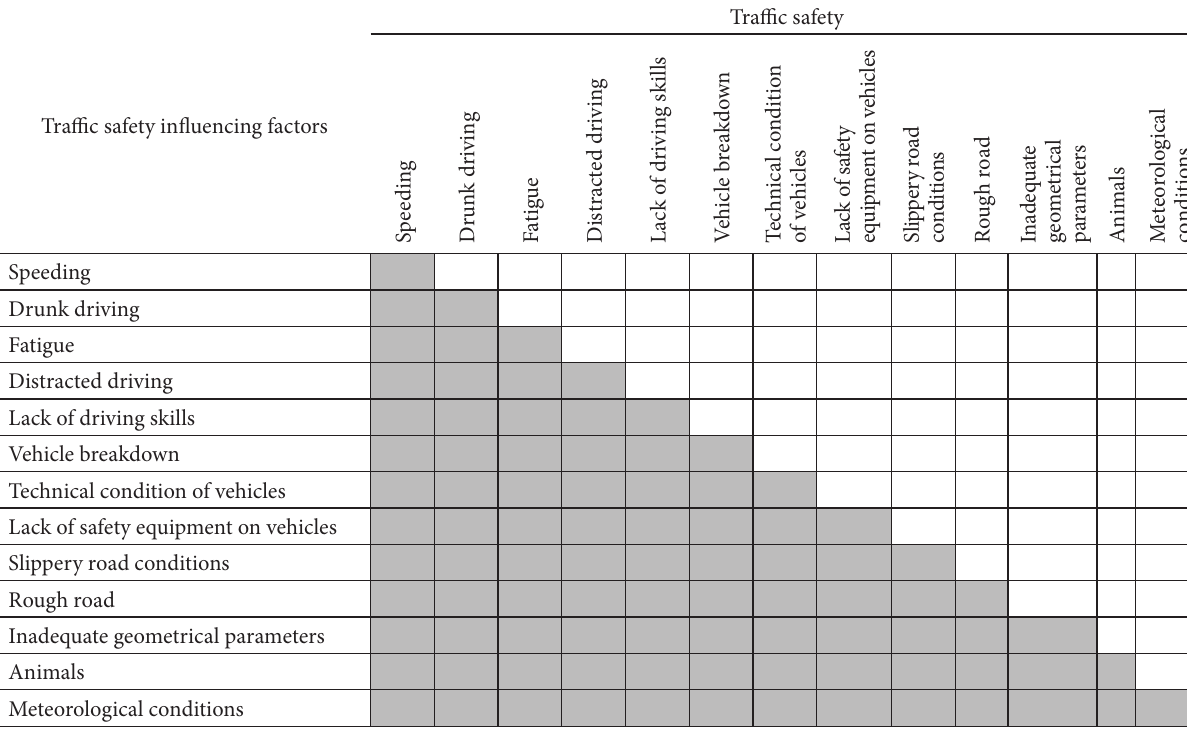
Table 1. Pairwise comparison of traffic safety influencing factors